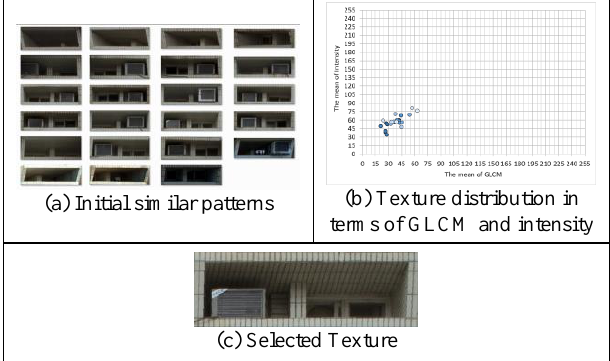
Figure 9. The results of optimal texture selection